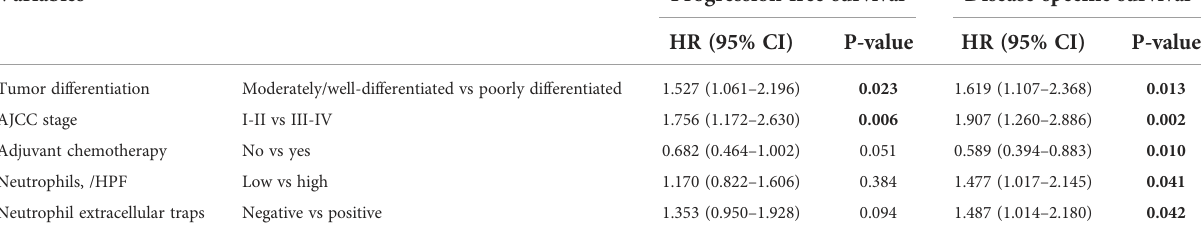
TABLE 3 Multivariate analysis of factors potentially predictive of survival in patients with pancreatic ductal adenocarcinoma. Variables